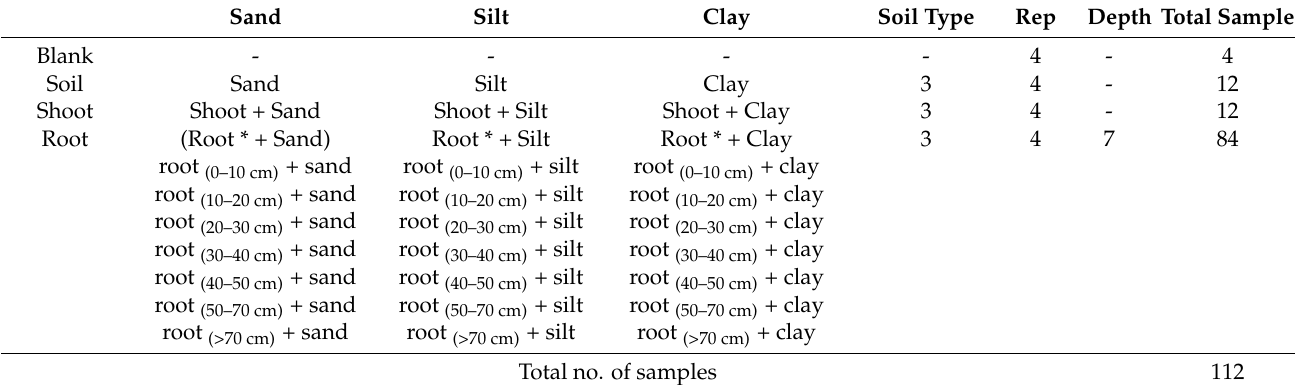
Table 8. Decomposition experiment design including blanks and the three soil types with no biomass added for reference, and soils (sand, silt and clay) with shoot and root (seven depth increments) biomass